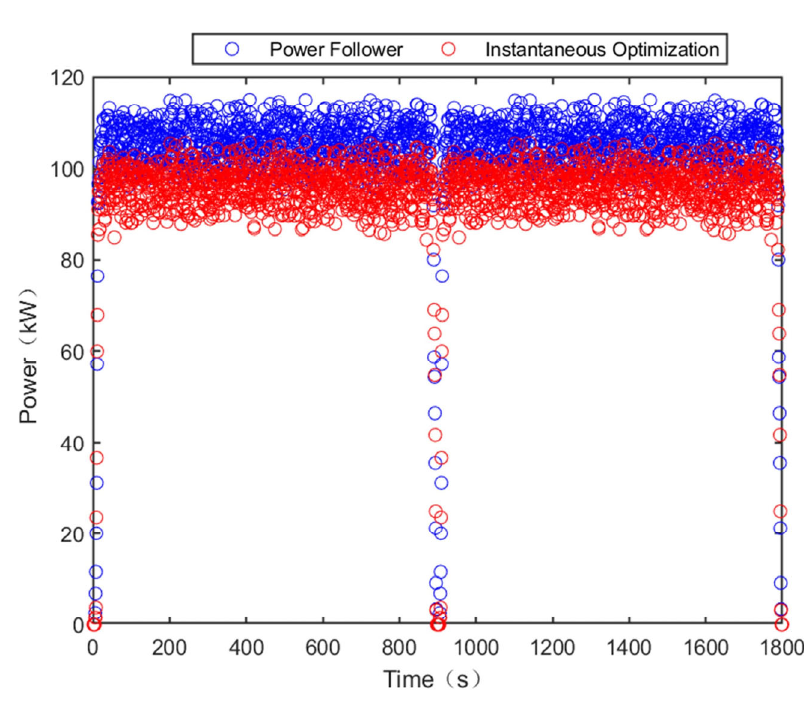
Figure 12. Working power of diesel engine.